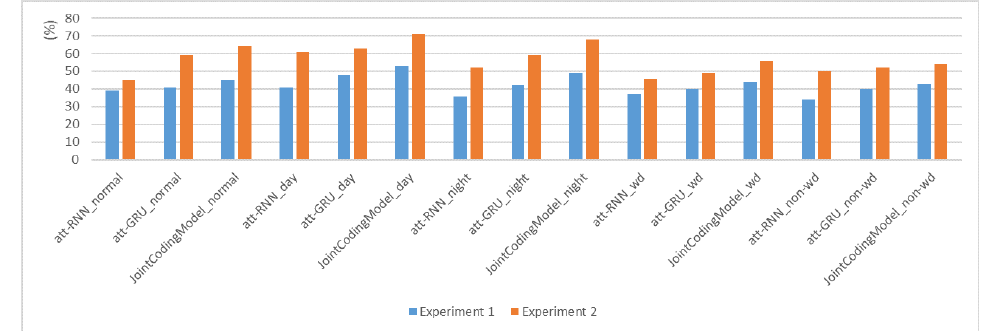
Figure 10. The results of Recall@20 with different dimensions in experiment 1 and experiment 2.